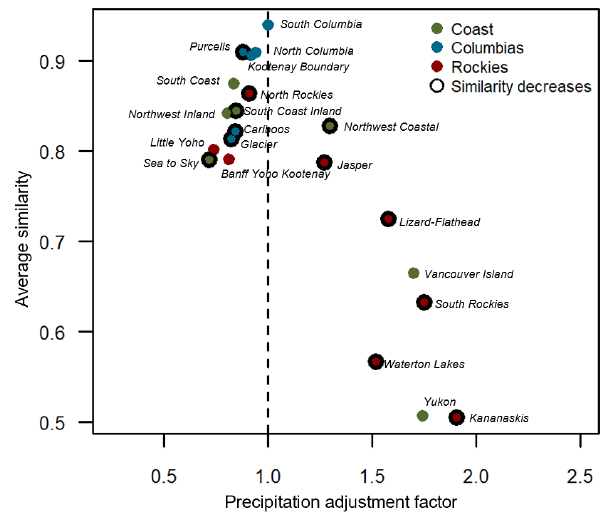
Figure 10. Average similarity in snowpack structure between orig- inal and precipitation-adjusted snow profiles at locations in each forecast region. The similarity is plotted against the magnitude of the precipitation-adjustment factor. Locations where the similarity has a statistically significant decrease over time are outlined with black